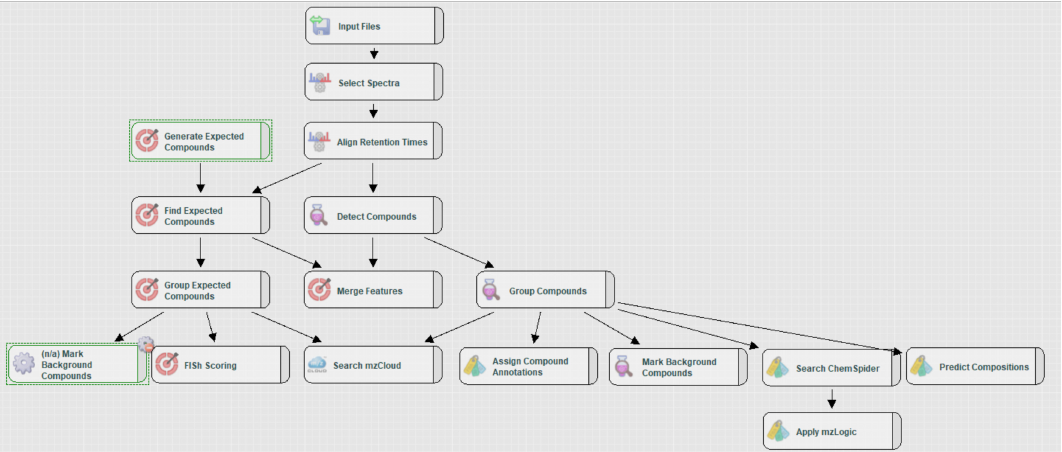
Figure 1. Workflow for processing HRMS